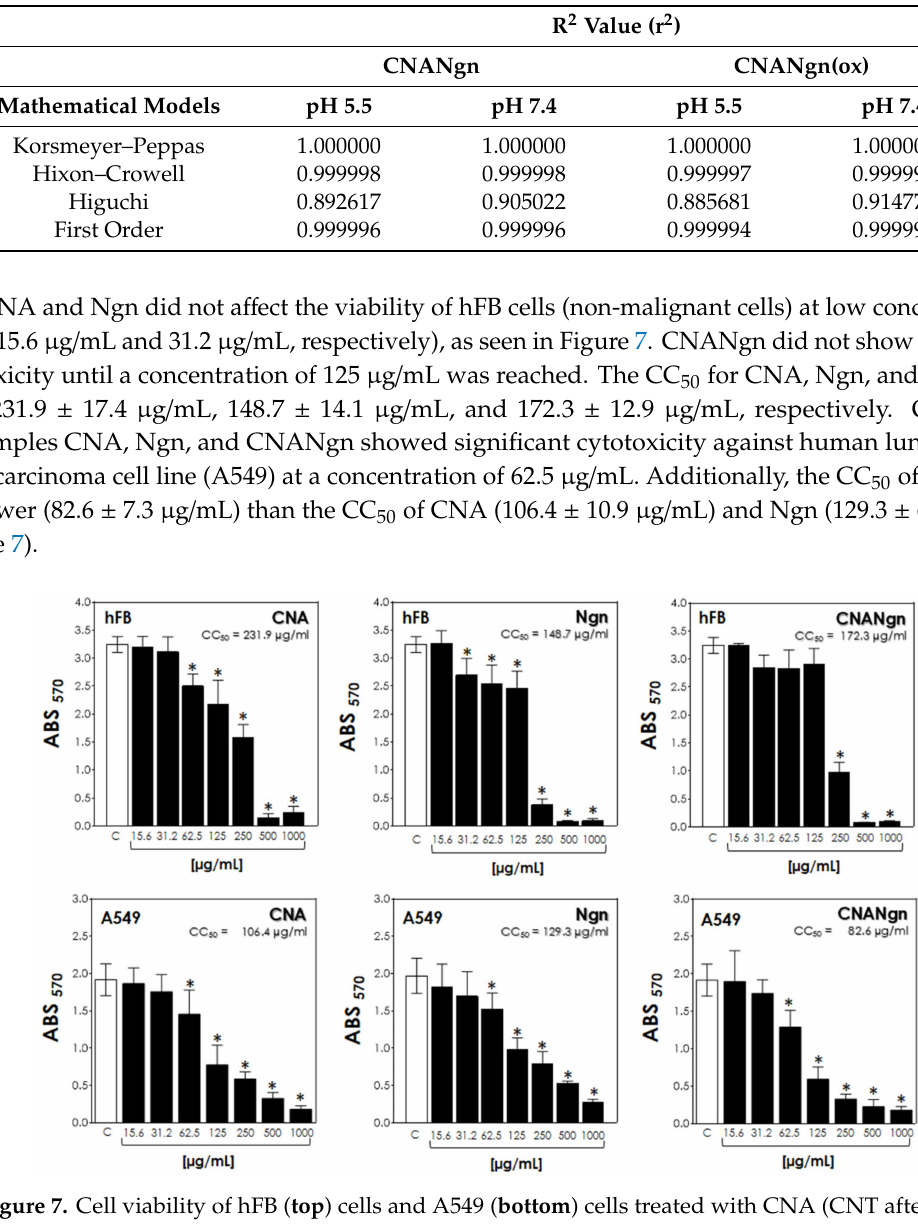
Table 2. R 2 values and kinetic parameters for mathematical modeling of Ngn release.